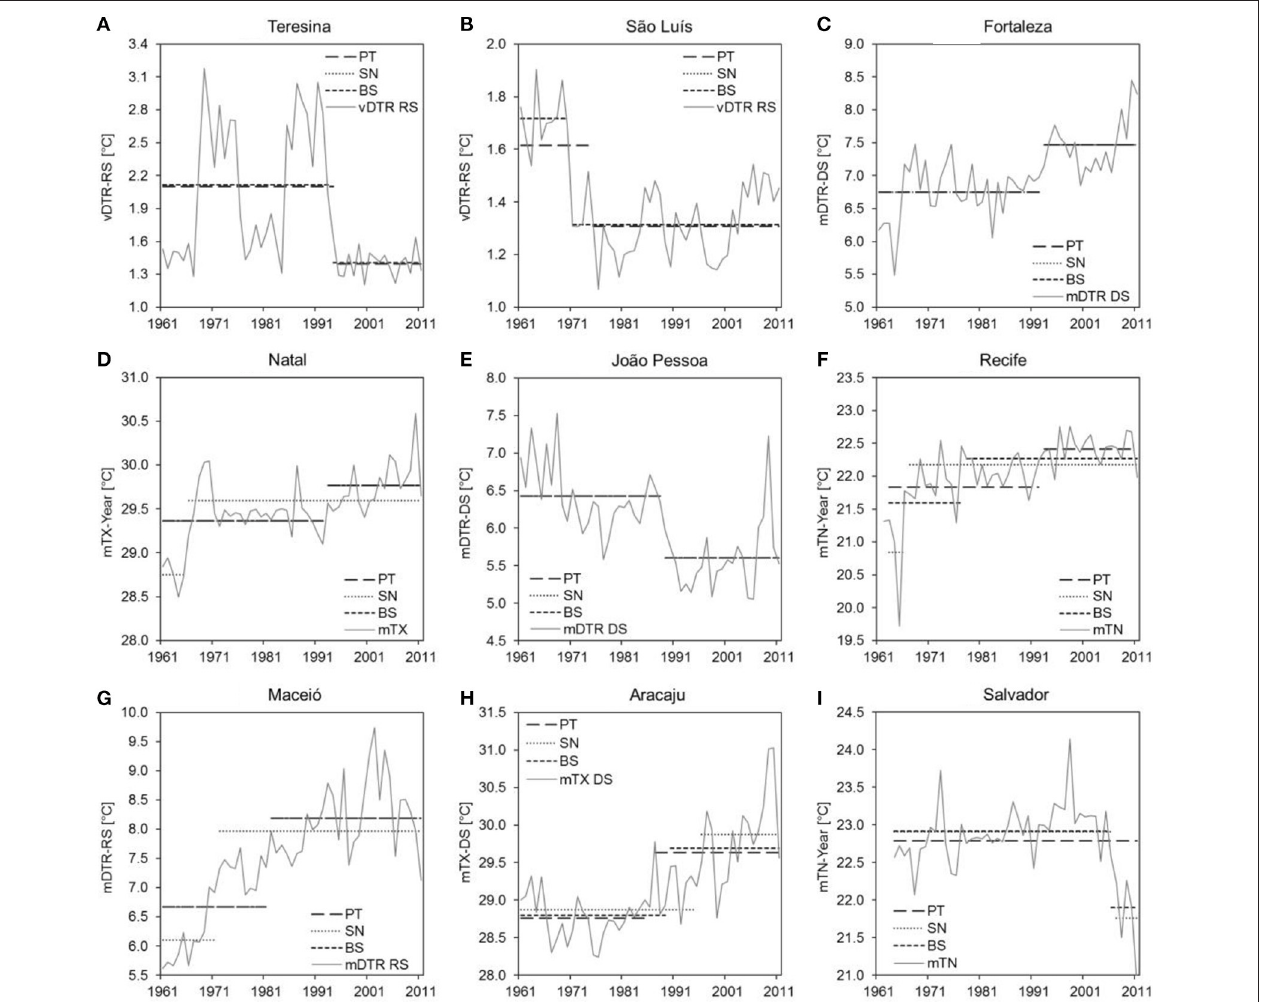
FIGURE 2 | Exemplary results of the homogeneity testing for the three tests (PT, Pettitt test; SN, Standard normal homogeneity test SNHT; BS, Buishand test) for (A) vDTR-RS (RS: rain season) at Teresina, (B) vDTR-RS at São Luís, (C) mDTR-DS (DS: dry season) at Fortaleza, (D) mTX at Natal, (E) mDTR-DS at João Pessoa, (F) mTN at Recife, (G) mDTR-RS at Maceió, (H) mTX-DS at Aracaju, (I) mTN at Salvador.